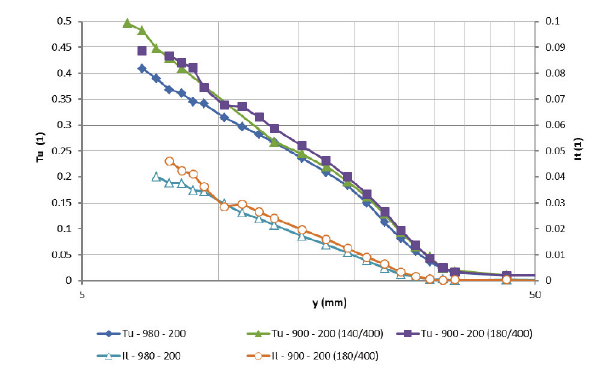
Fig. 10 Intensit and intensity of